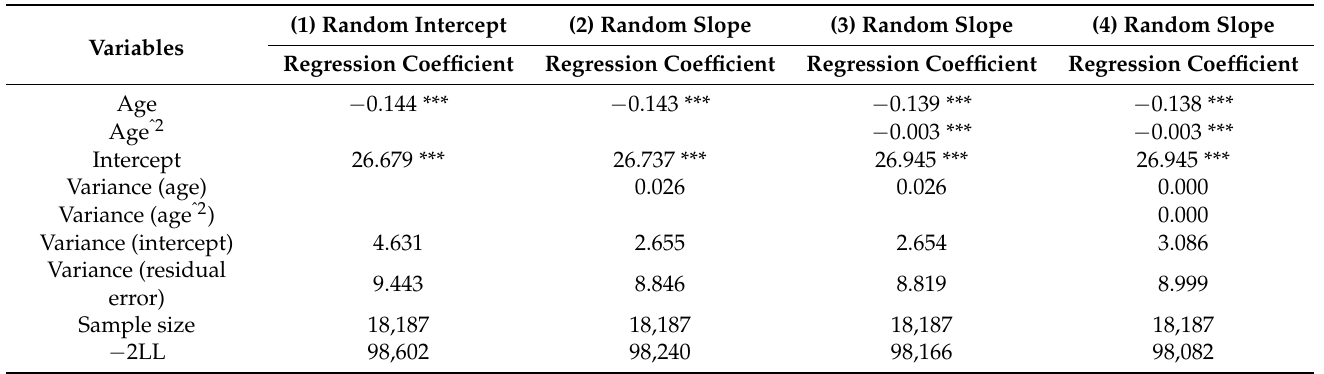
Table 2. The random effect of changes in elderly people’s cognitive